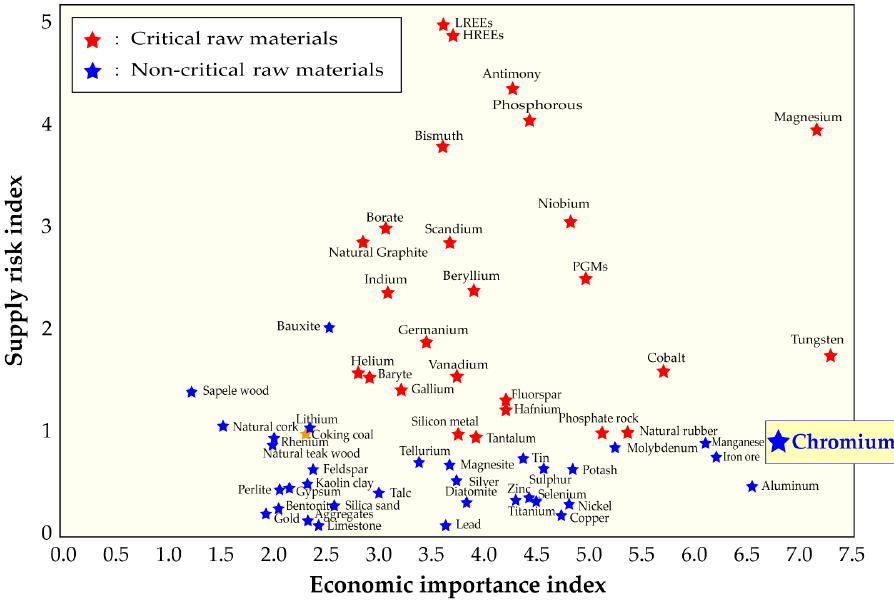
Figure 1. The 2017 criticality assessment of raw materials for the European Union.